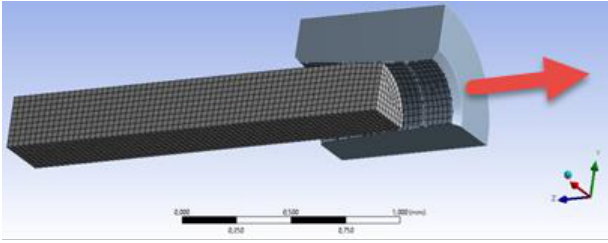
Figure 2. An illustration of the geometrical layout and the mesh of finite elements used in numerical simulations. The red arrow indicates the drawing direction.